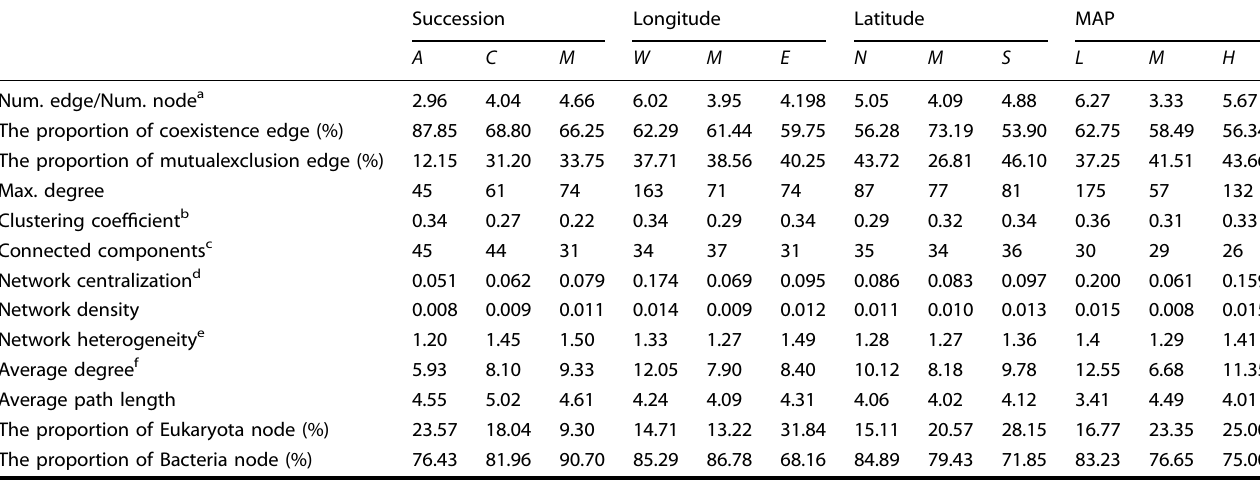
Table 2. The topological characteristics of the co-occurrence network. Succession Longitude Latitude